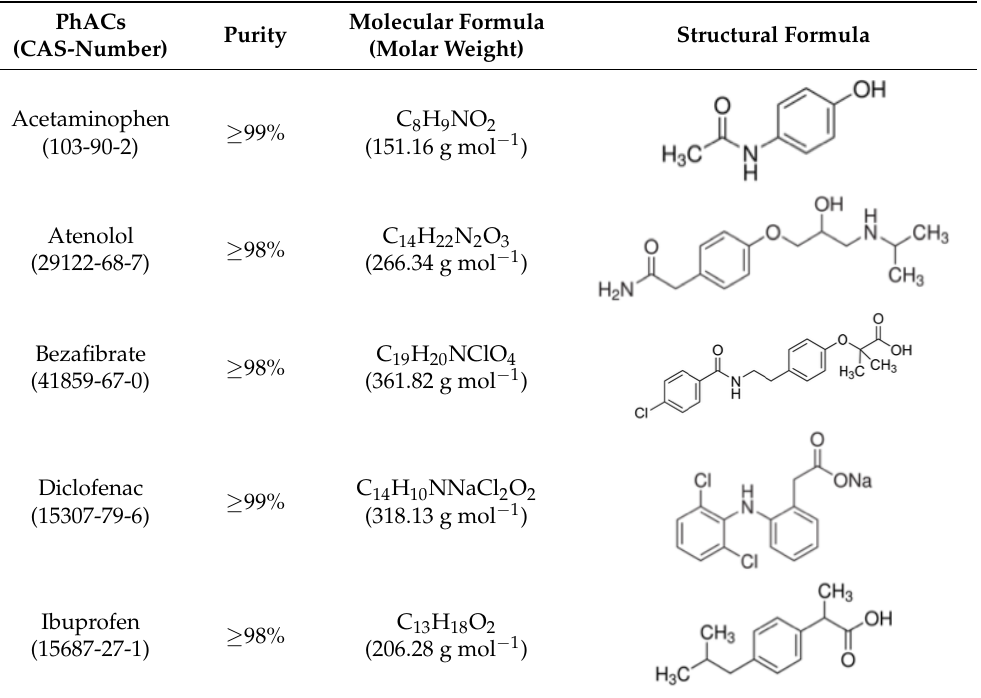
Table 1. CAS-number, purity, molar weight, molecular and structural formulas of the PhACs selected.